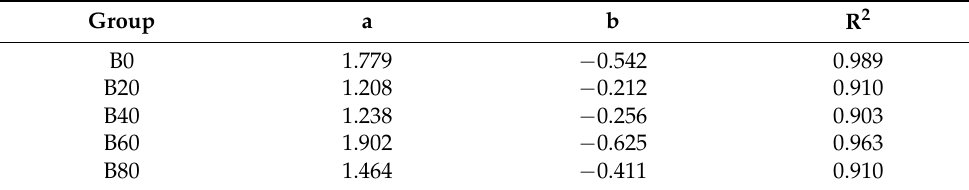
Table 2. Mortar dimensionless permeability fitting parameters.